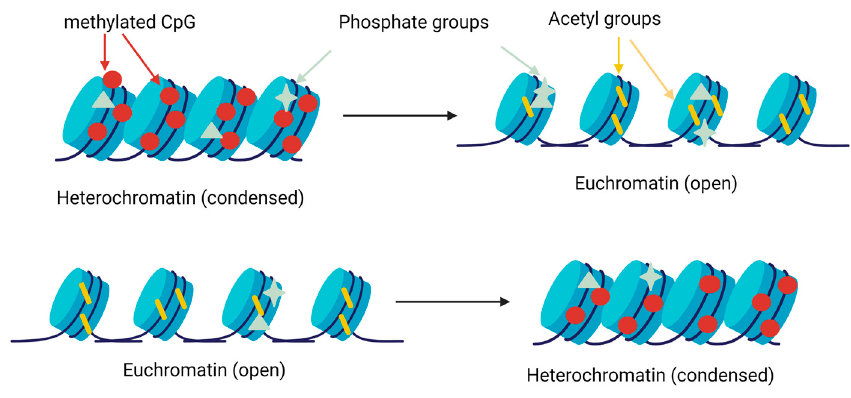
Figure 3. Scheme of the gene expression regulation by histone modifications. Methyltransferases add methyl groups in lysine and arginine residues, favouring chromatin condensation and preventing gene expression. Acetyltransferases and deacetylases add or remove acetyl group in lysine residues, decreasing or increasing, respectively, the condensation of chromatin. The kinases and phosphatases add phosphate groups in different locations, changing the condensation of chromatin [43].